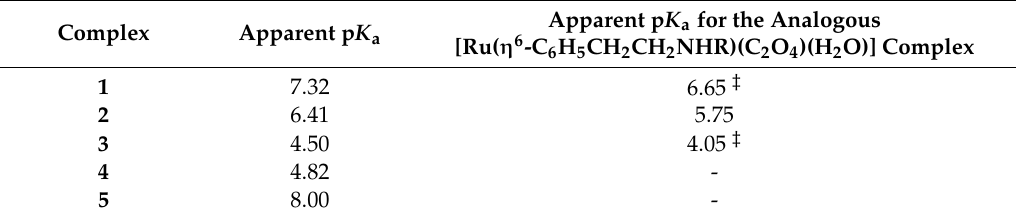
Table 1. Apparent p K a values determined for 1 – 5 and their [Ru( η 6 -C 6 H 5 CH 2 CH 2 NHR)(C 2 O 4 )(H 2 O)] analogues.